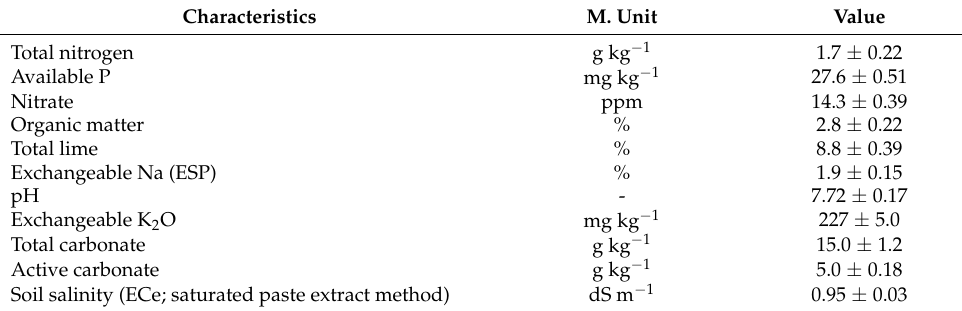
Table 1. Soil chemical properties at the experimental study